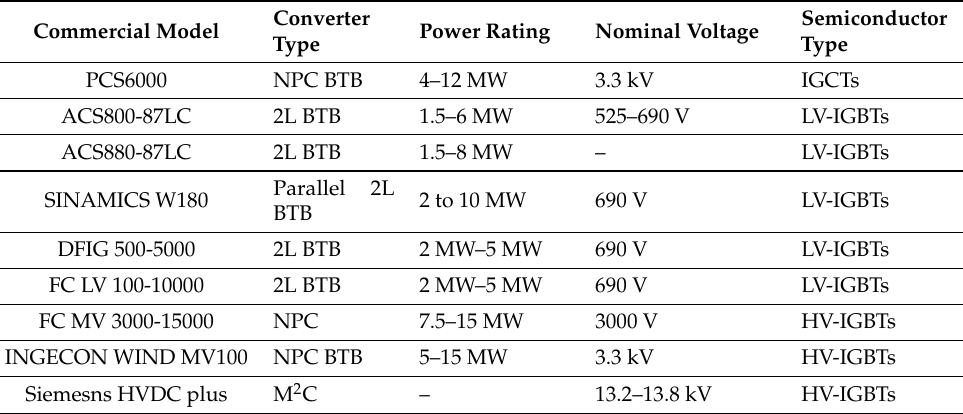
Table 5. List of commercially available power